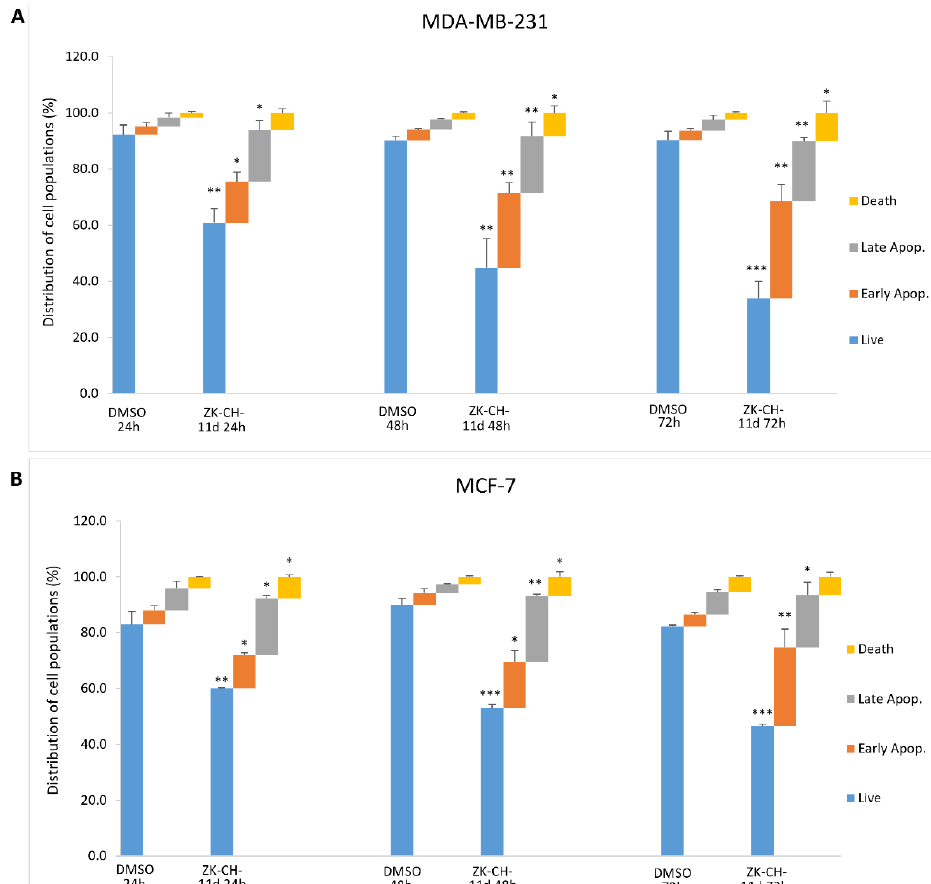
Figure 8. Flow cytometric analysis of ZK-CH-11d-induced apoptosis in MDA-MB-231 ( A ) and MCF-7 ( B ) cells after treatment for 24, 48, and 72 h. Data are presented as the mean of three independent experiments as the mean percentage ± SD. Statistical significance: * p < 0.05, ** p < 0.01, *** p < 0.001 vs. vehicle (DMSO).